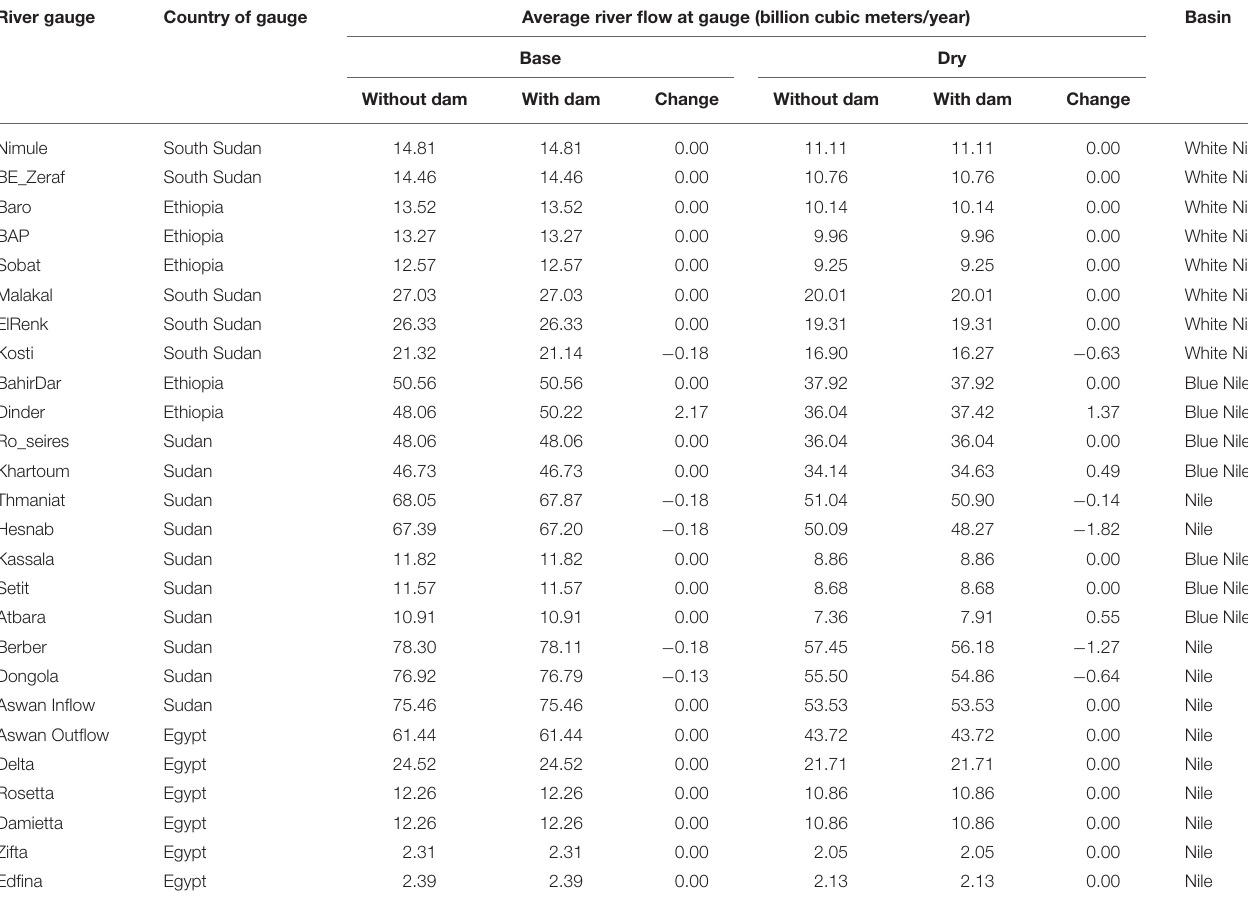
TABLE 2 | Hydroeconomic model results illustration—predicted streamflow by gauge, policy, and scenario, averaged over 20 years, Nile Basin. River gauge